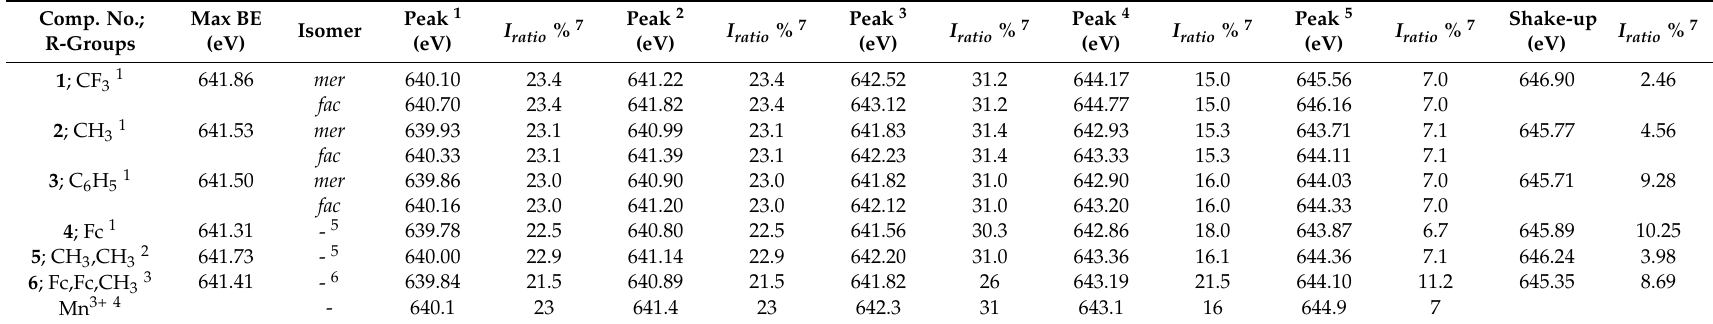
Table 2. Maximum binding energy, BE, of the Mn 2p 3/2 envelope, the binding energies of each multiplet split peak and I ratio %’s for the multiplet splitting of the Mn 2p 3/2 peak. BE of the shake-up (charge transfer peak) is also shown. Comp. No.;